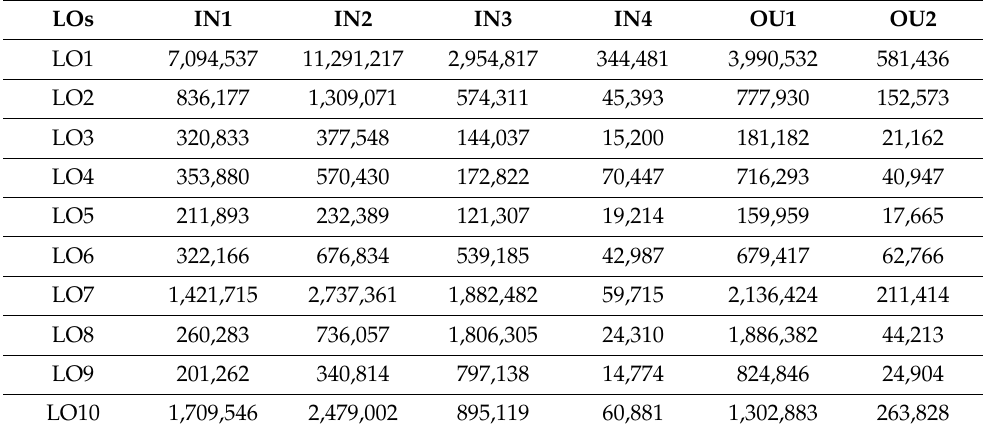
Table 2. Data of 10 LOs in 2017 (Statistics 2021).